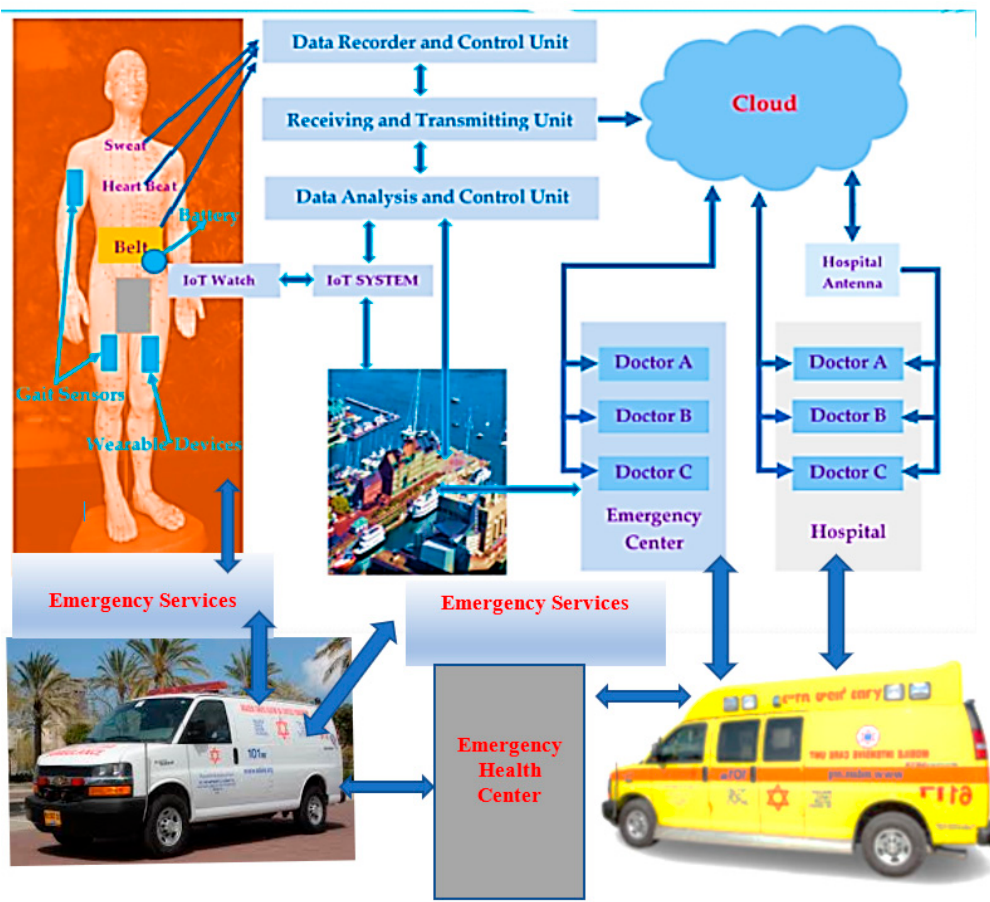
Figure 26. Global Medical monitoring health system with WBAN and BAN Systems.